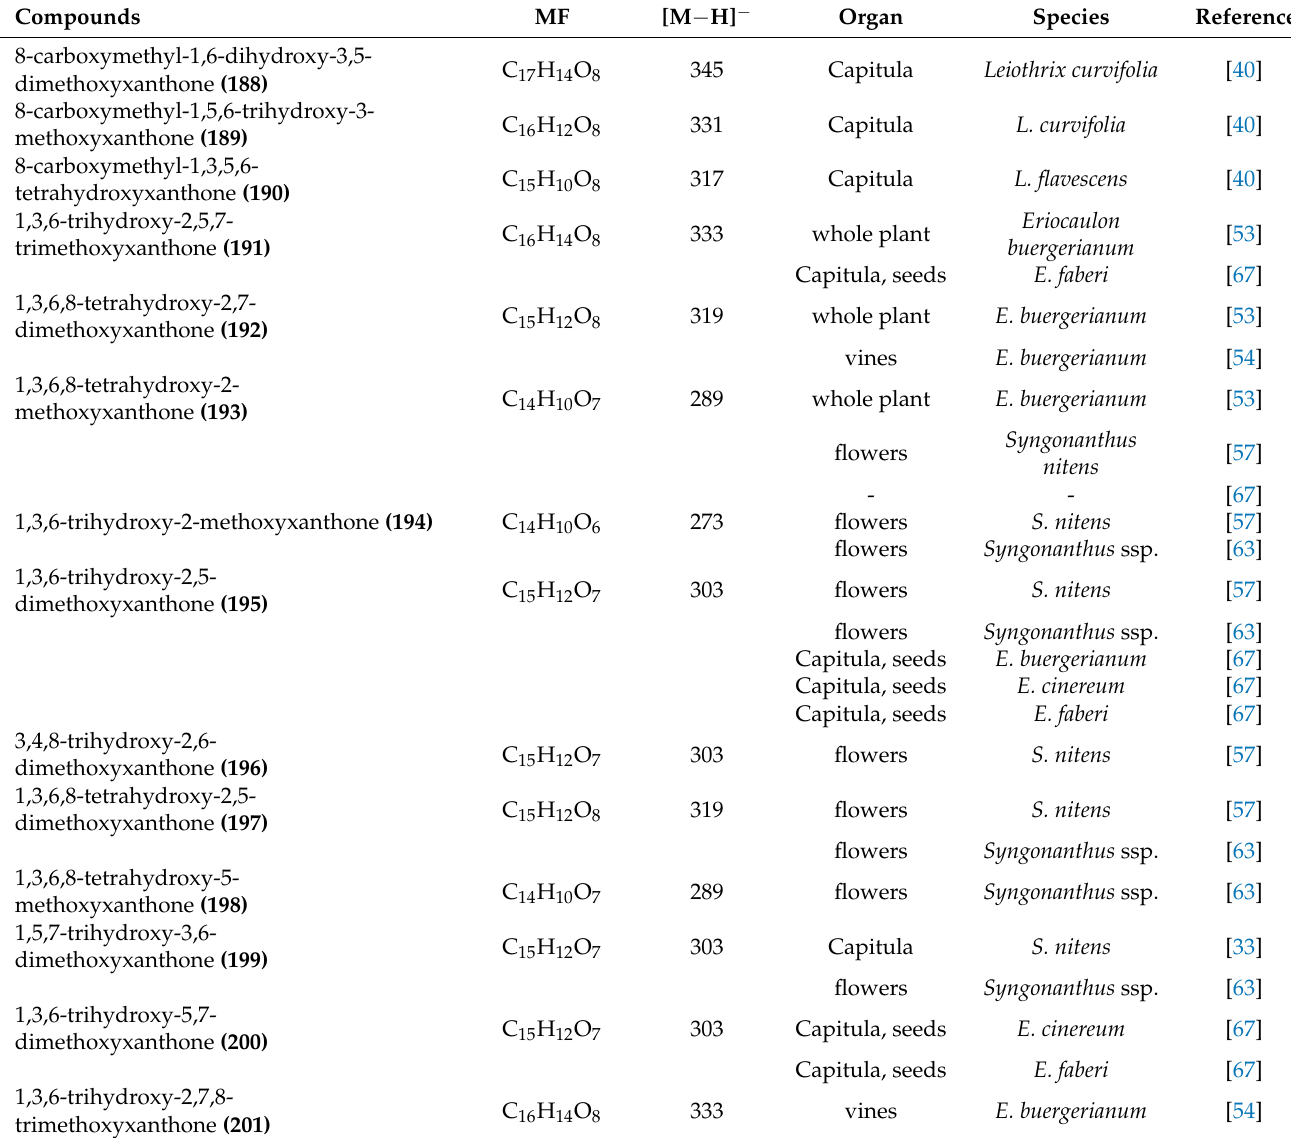
Table 4. Xanthones isolated in Eriocaulaceae